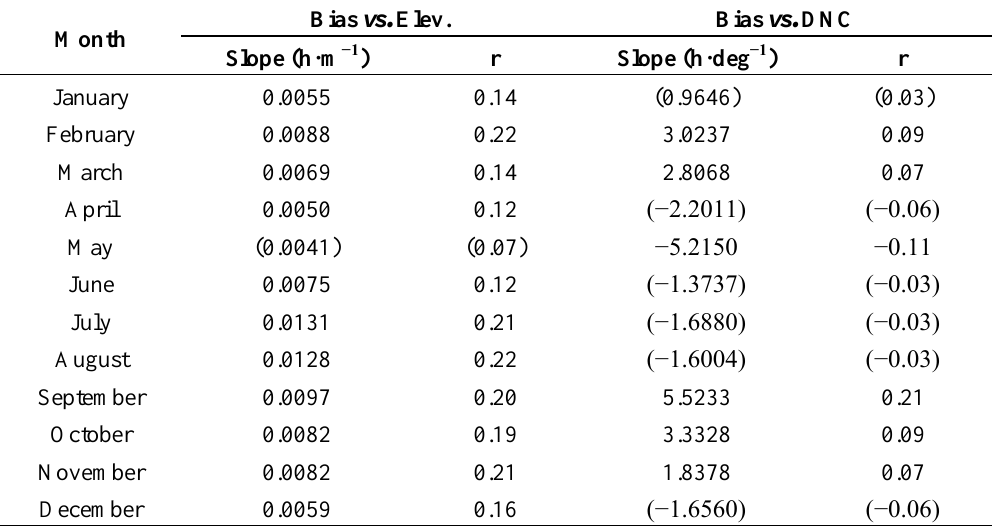
Table 5. Grid box minus station SD validation statistics for the SD-RCC product for 2008 (monthly totals) using non-CLIMAT stations for validation. The table shows results for mean monthly bias (for each station) vs . elevation and mean monthly bias vs . the distance to the nearest CLIMAT station for that SD-RCC grid box (DNC). “Slope” denotes the gradient of the linear regression line fitted to the data. “r” denotes Pearson correlation coefficient. Results shown in parentheses are insignificant at the 5% level. The number of stations used in the analysis varies between 616 (January) and 800 (July). Bias vs. Month